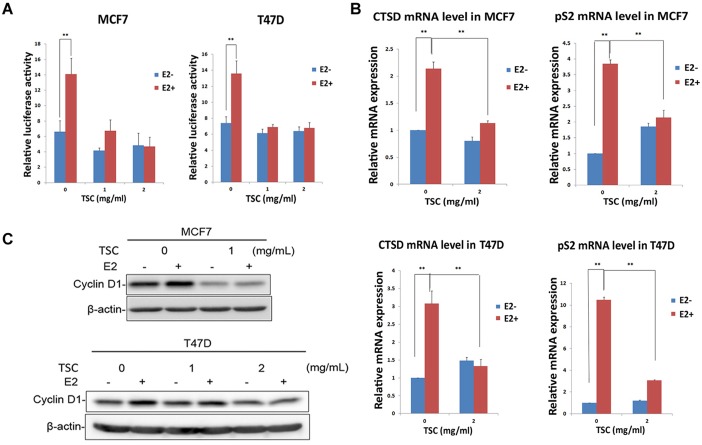
TSC inhibits the estrogen signal pathway.A. TSC inhibited the transcriptional activation of ERα in response to E2 in both MCF7 and T47D, as measured by the ERE luciferase reporter assay. **, P<0.01. B. TSC blocked the E2-induced CTSD and pS2 mRNA expression in both MCF7 and T47D, as measured by real-time PCR. **, P<0.01. C. TSC blocked the induction of Cyclin D1 by E2 in MCF7 and T47D cells. The E2 concentration was 10 nM.